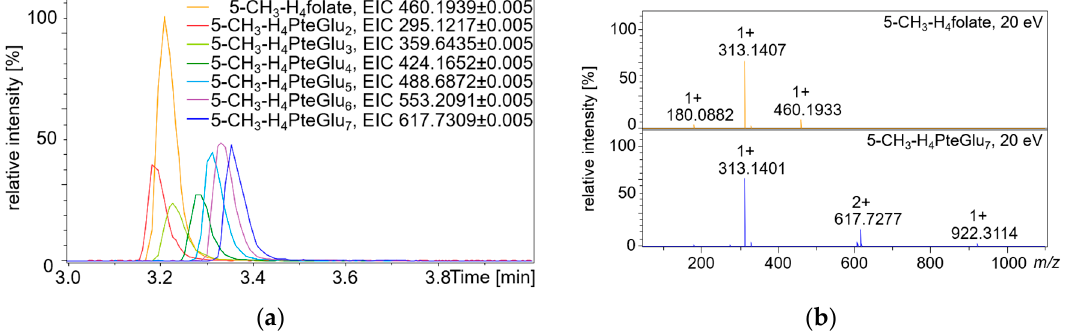
Figure 4. 5-CH 3 H 4 folat standard and synthesized folate standards 5-CH 3 -H 4 PteGlu 2–7 measured